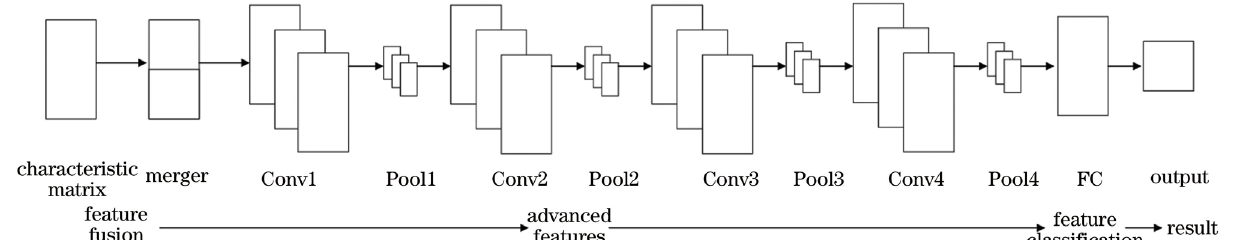
Figure 4 . CNN-Fusion